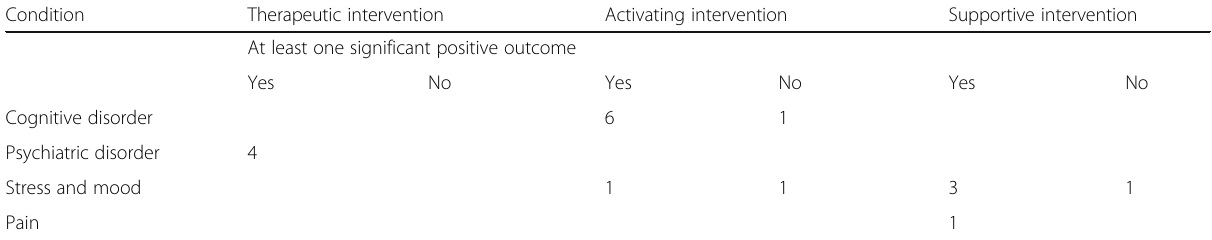
Table 5 Number of studies divided into condition, type of intervention, and the presence of positive outcome